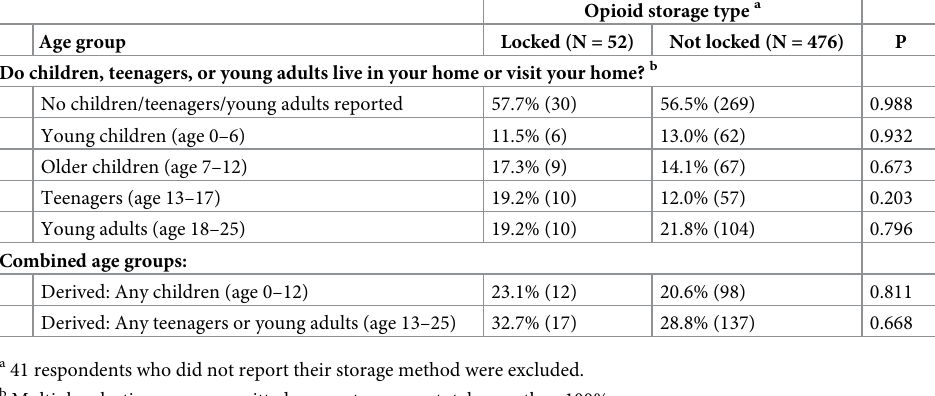
Table 4. Presence of children, teenagers and/or young adults in the household versus opioid storage method, among current and former opioid